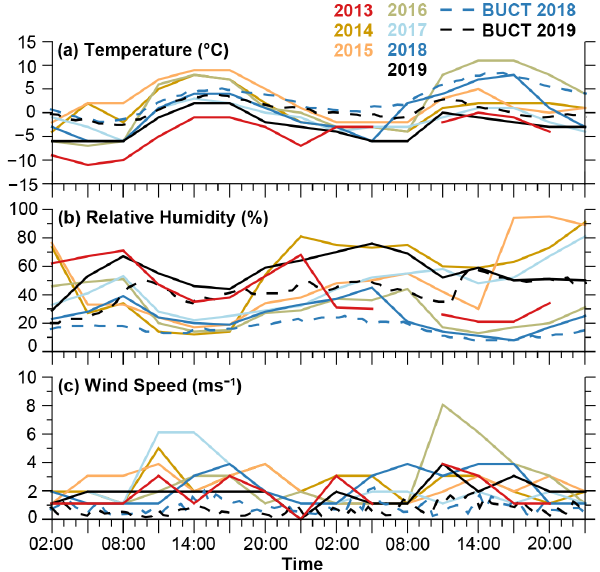
Figure 3. Meteorological conditions during CNY night ± 1d mea- sured in Beijing from 2013–2019. Solid lines are measurements from Beijing Nanyuan Airport (ZBNY). These measurements are every 3h. Dashed lines are measurements at BUCT-AHL during 2018–2019, with a time resolution of